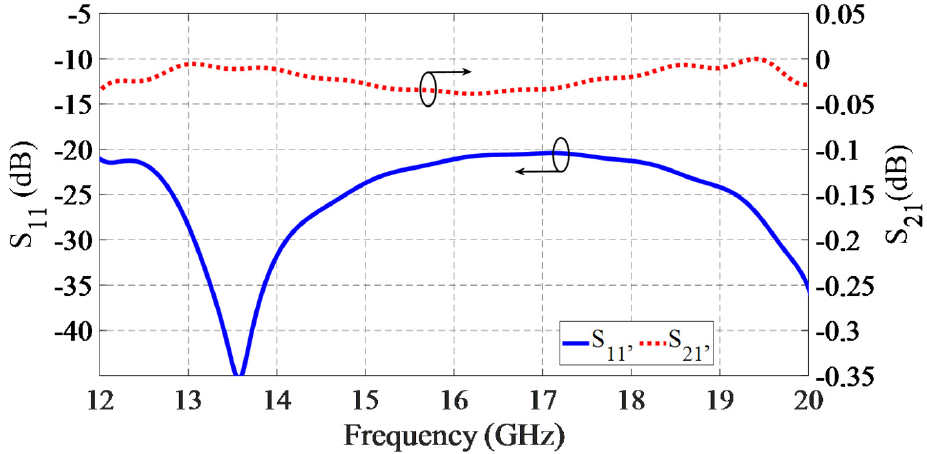
Figure 3. Simulated S-parameters of WR62 to GGW transition.